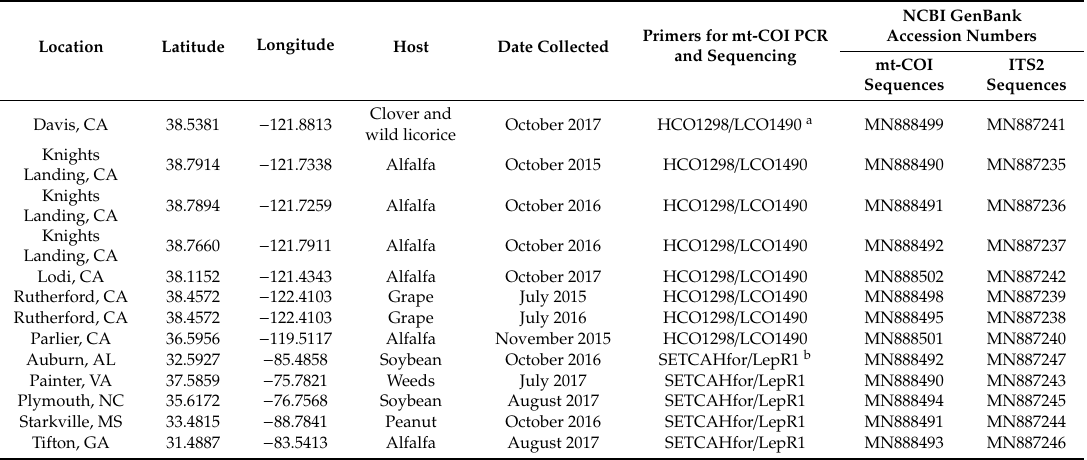
Table 1. Sites of Spissistilus festinus collection, date of collection, mt-COI primers used for PCR characterization and sequencing, and NCBI GenBank accession